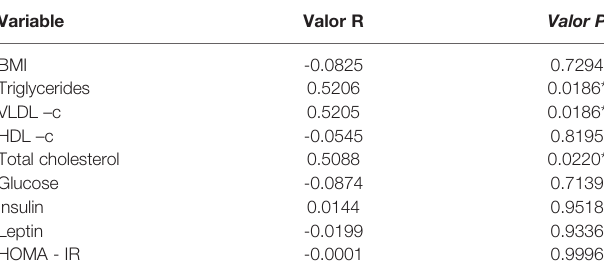
TABLE 2 | Pearson ’ s correlation coef fi cient between serum ANGPTL3 levels and study variables in healthy non – pregnant women. Variable